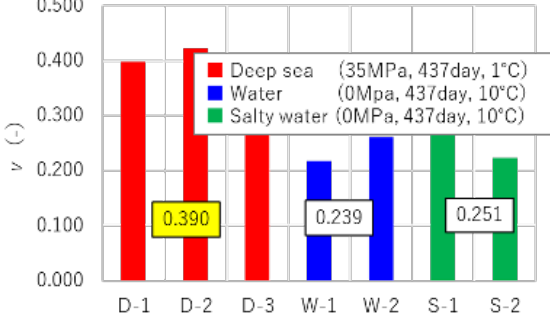
Figure 7. Results of compression testing.